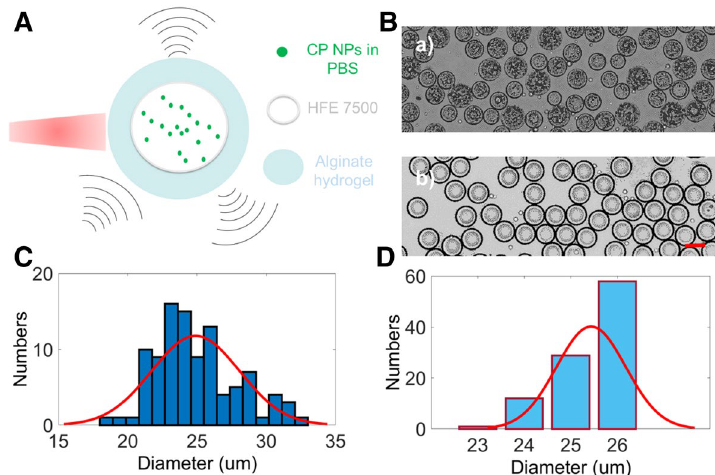
Figure 1. Schematic diagram and size distributions of the microdroplets: ( A ) The structure of the microdroplets consists of three layers: alginate hydrogel (aqueous phase)—HFE 7500 (oil phase)—CP NPs in PBS solution (aqueous phase) from outside to inside. ( B ) (a,b) are the images of microdroplets manufactured with and without surfactants, respectively. The scale bar is 25 μm. ( C ) Size distribution of the microdroplets with surfactants. The mean value of the normal distribution fit is 24.9 μm. ( D ) Size distribution of the microdroplets without surfactants. It has a mean value of 25.6 μm although is not normally